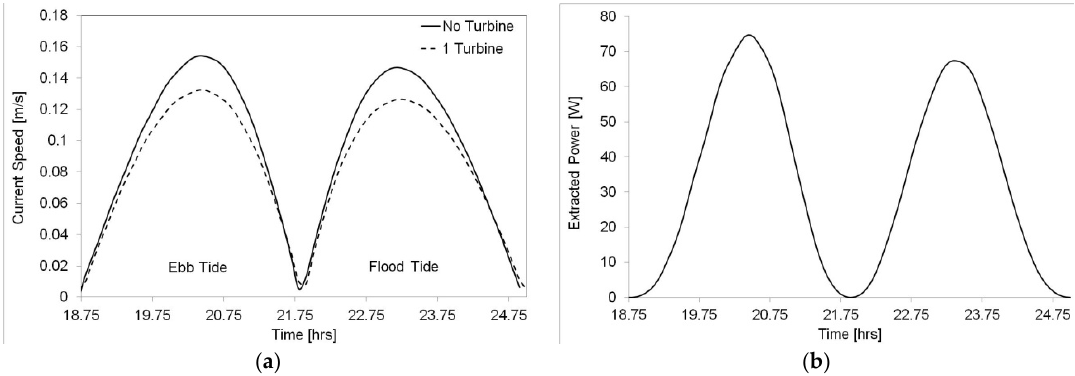
Figure 8. ( a ) Time series of current speeds at the location of the turbine with and without the single turbine and ( b ) time series of power capture by the turbine over a tidal cycle.